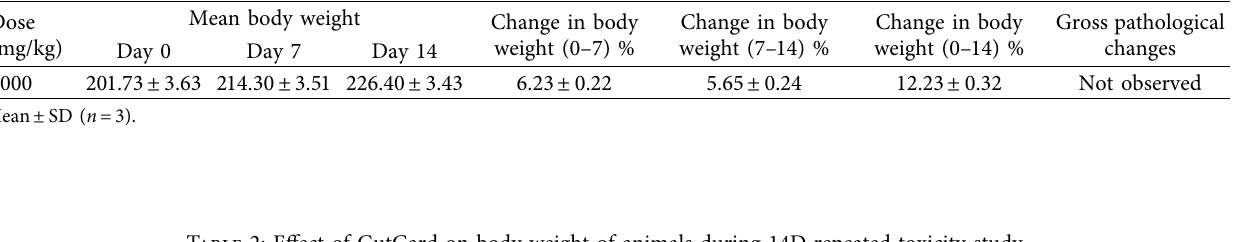
Table 2: Effect of GutGard on body weight of animals during 14D repeated toxicity study. Group Dose (mg/kg)